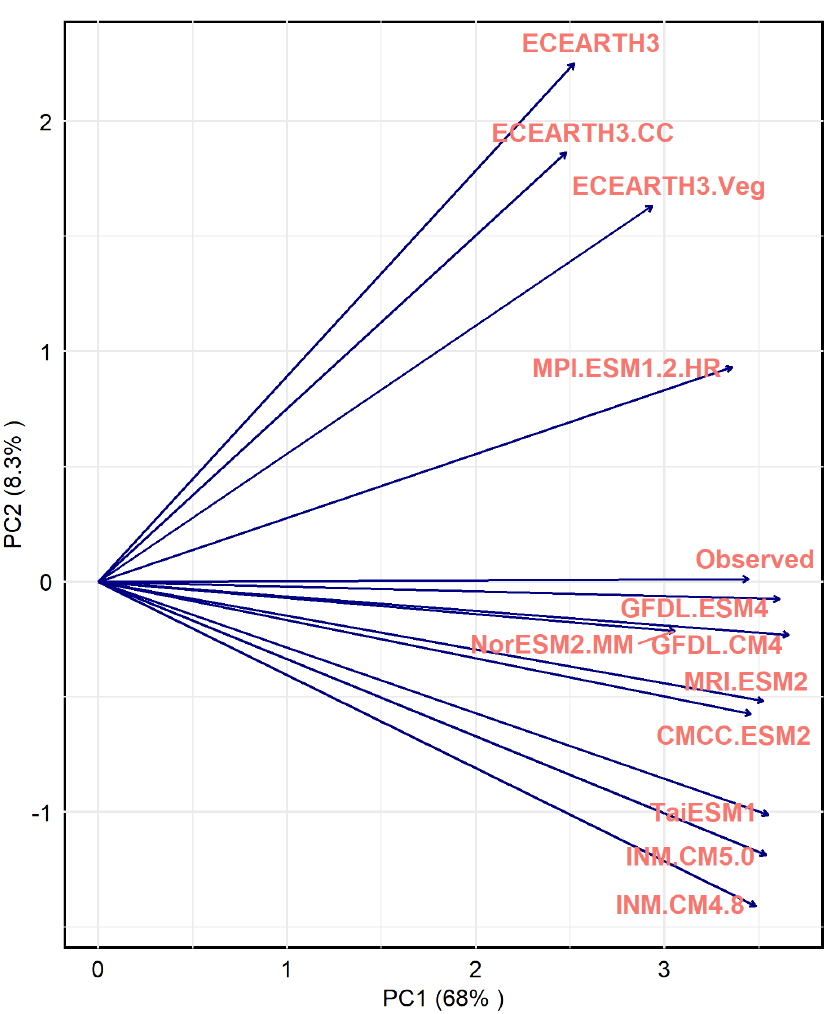
Figure 8. PCA biplot for the monthly minimum temperature series of the observed and climate model series. The figure on the left is a zoomed-out part of the main biplot on the right. Similarly, the correlation box plots for the maximum temperature series (Figure 10) show that two models, MPI-ESM1-2-HR and ECEARTH3, were better correlated; MRI- ESM2 performed the